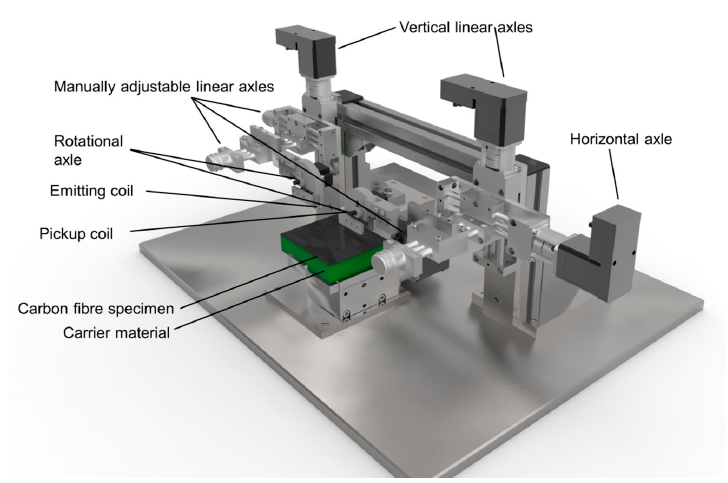
Figure 3. Measurement rig for the determination of optimal sensor designs.